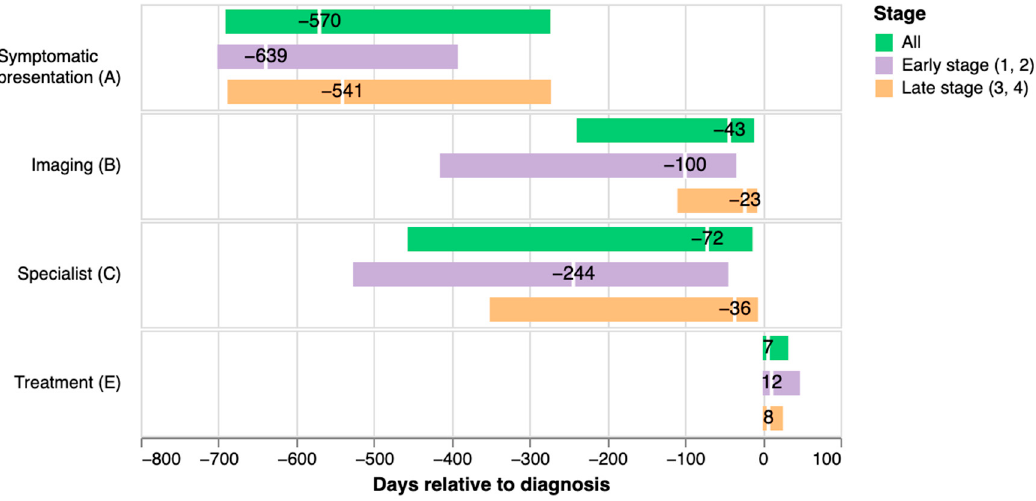
Figure 4. Median number of days prior to diagnosis for initial symptomatic presentation, chest CT or chest X-ray imaging, cancer specialist visit, and after diagnosis for initiation of treatment by stage of lung cancer. Note: Imaging includes chest X-ray or chest CT.